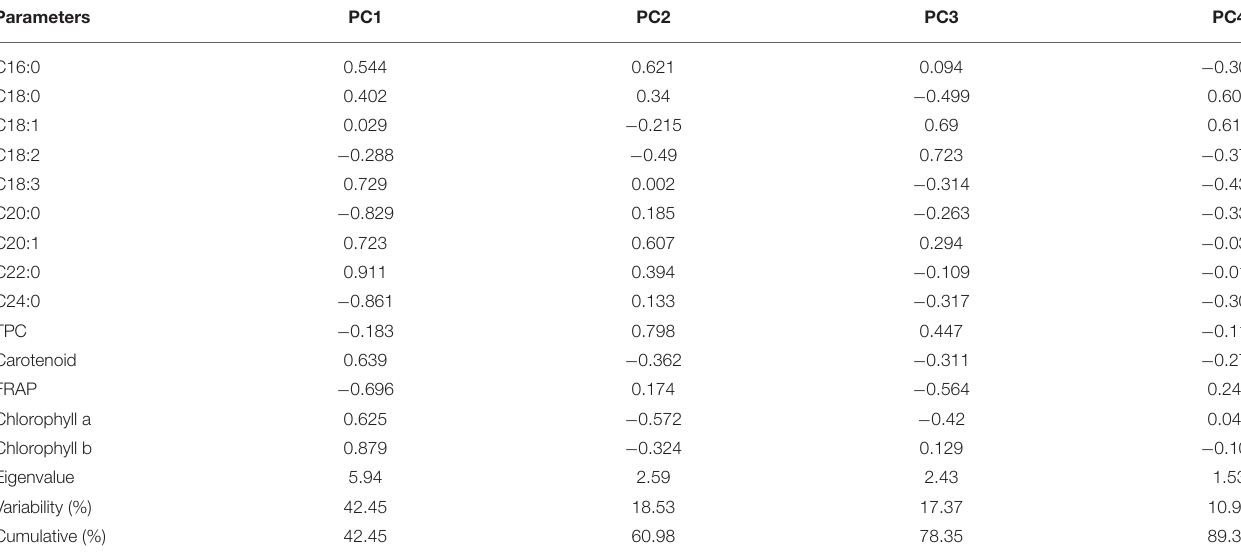
TABLE 6 | Eigen analysis of the loadings of the significant principal components (PCs) for the linseed varieties.